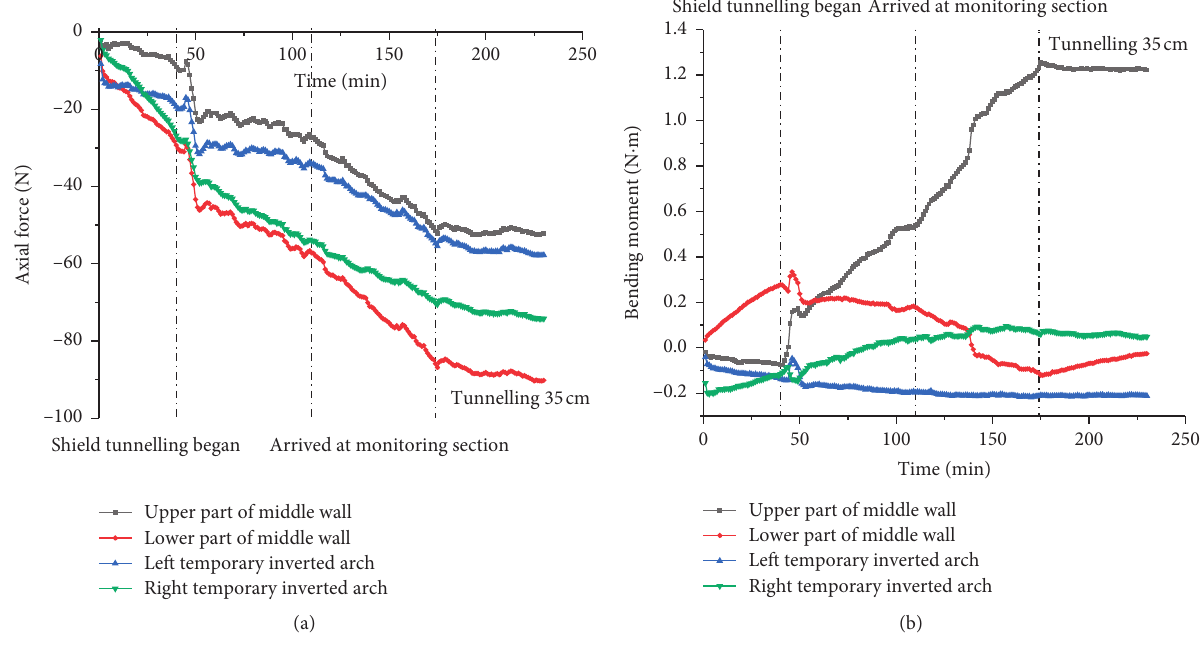
Figure 17: Time-history curve of internal force in temporary support. (a) Axial force curve of temporary support; (b) bending moment curve of temporary